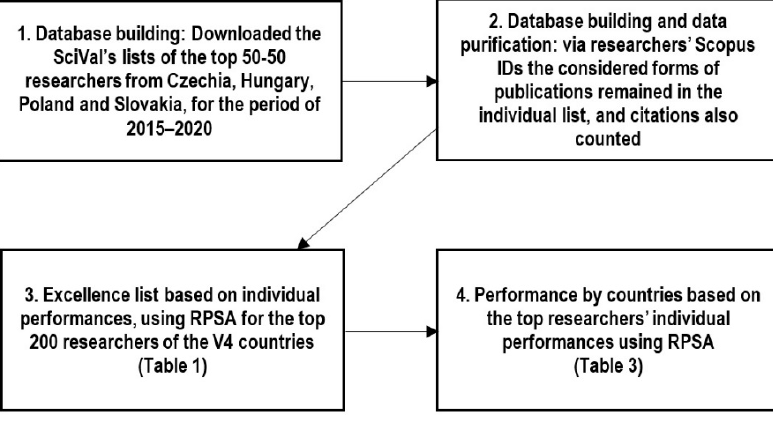
Figure 1. The research